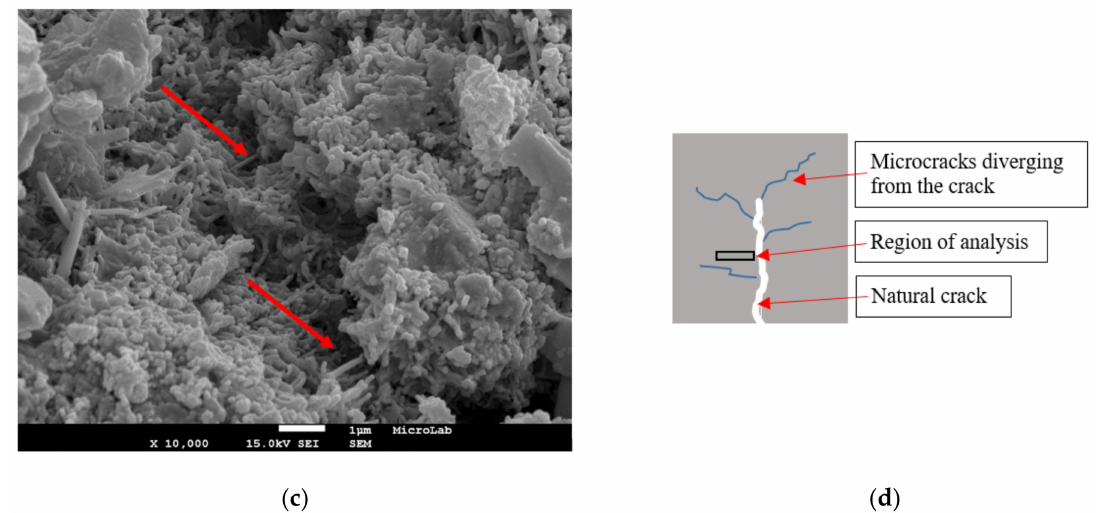
Figure 7. ( a – c ) SEM analysis of CNTRC with natural cracking (arrows indicate CNT tips or bridging). ( d ) scheme of concrete region analyzed in SEM analysis.